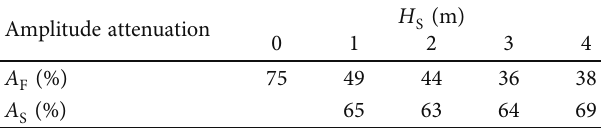
(1 ~ 5 working cases). S